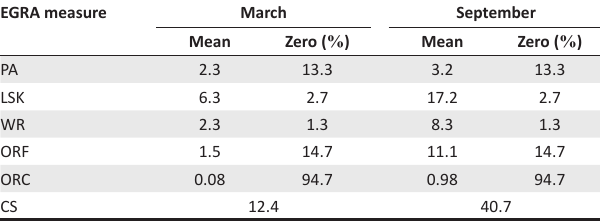
TABLE 2: Baseline and endline statistics of overall learner